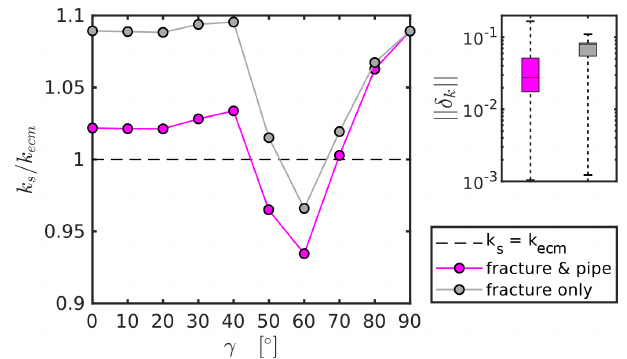
Figure 6. The left panel shows a comparison of directional per- meabilities obtained from high-resolution Stokes flow simulations ( k s ) and counterparts ( k ecm ) analytically derived with the ECM ap- proach described in the text as a function of the angle γ between the intersection and the principal flow direction. Magenta dots rep- resent the mean permeability ratios (10 values per point) for the ECM approach described in Sect. 4 with the half-hypotenuse pipe radius parameterization. Gray dots present the mean permeability ratio for an ECM approach that ignores the effect of intersections. The right panel shows a box plot of the error norm || δ k || computed according to Eq. (15) with k ecm as k r for all 100 fracture-and-pipe (magenta) and fracture-only models